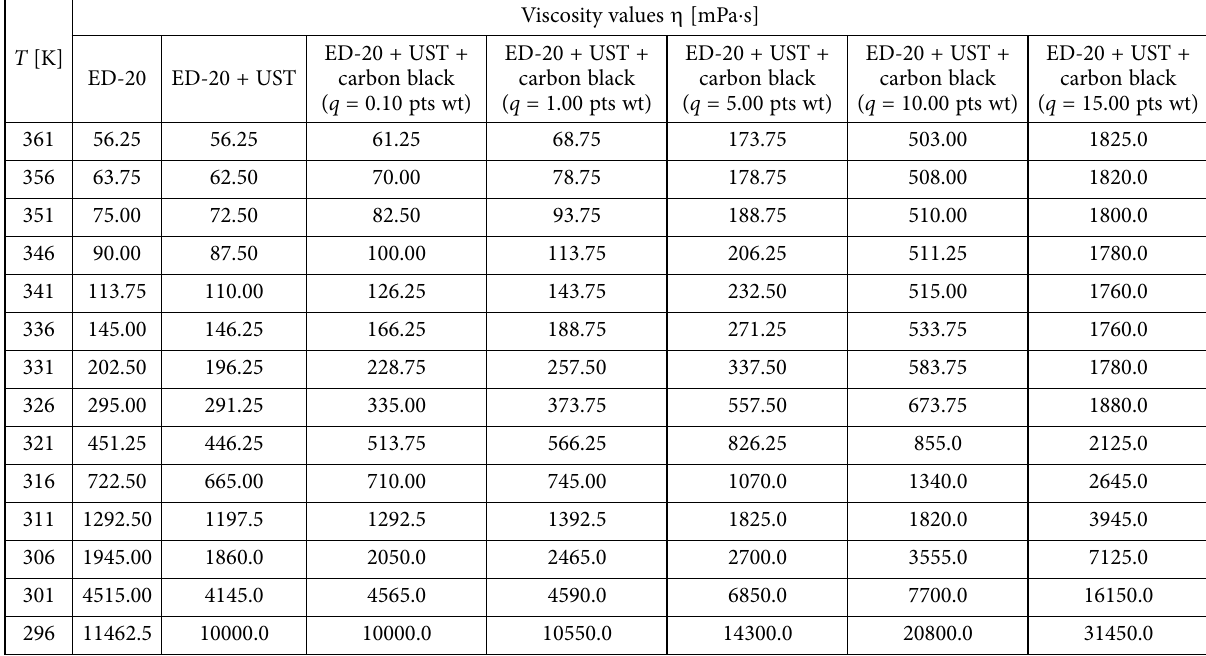
Table 3. Viscosity values of the epoxy composition based on epoxy resin ED-20 at various temperatures and concentrations of the filler